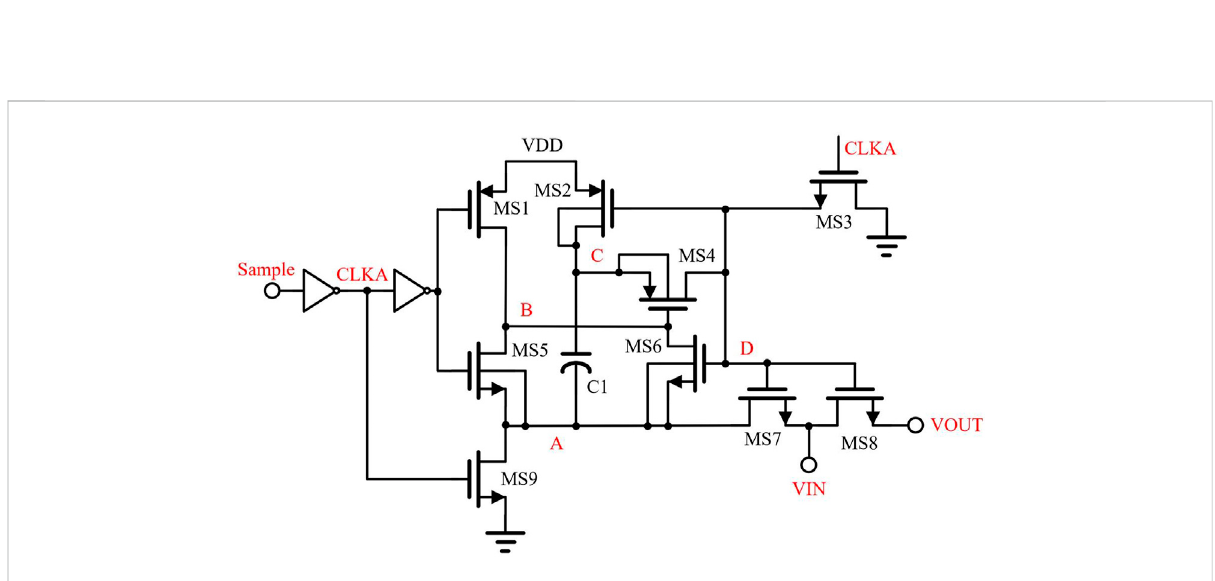
FIGURE 5 Bootstrapped sampling